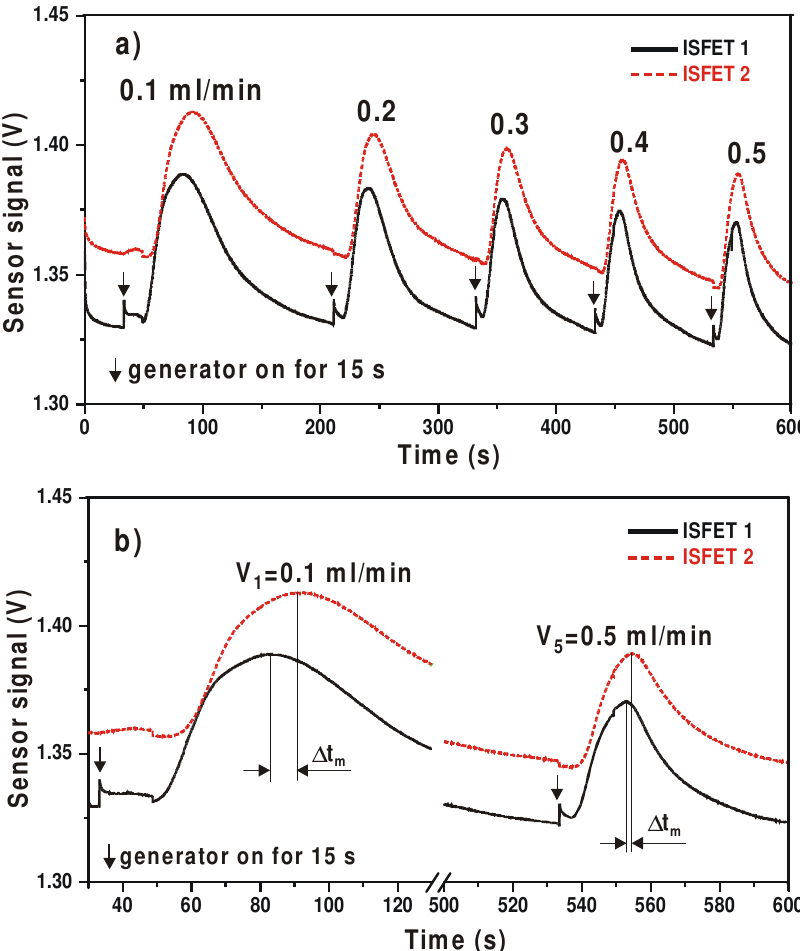
Figure 4. Response of the flow-velocity sensor under short ion-pulse generation at different flow rates from 0.1 to 0.5 ml/min (a) and determination of the time of flight (b). In this experiment, H + - ions were generated at a constant current of 30 µA for about 15 s. The arrows mark the time of beginning of ion generation. The time of flight has been evaluated as a time difference D t between the signal maxima of the two